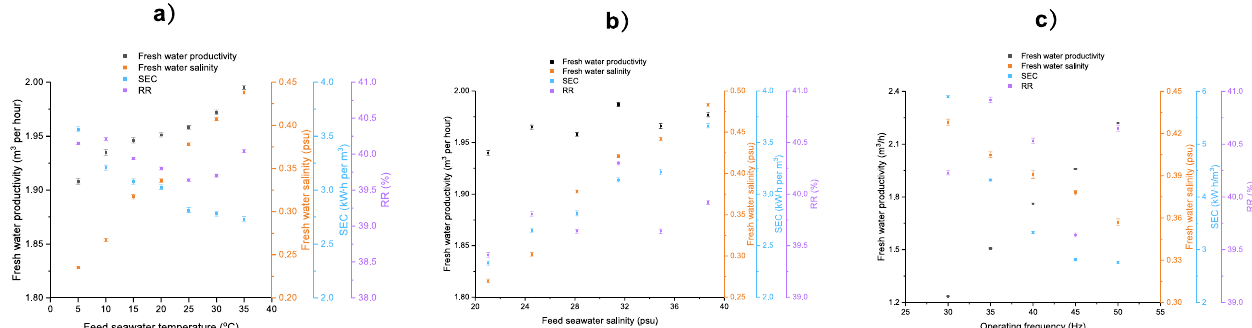
Fig. 1 System performance fl uctuations under variable operating conditions. a The in fl uences of feed seawater temperature on fresh water salinity, SEC of RO process and RR of RO system are portrayed. b The in fl uences of feed seawater salinity on fresh water salinity, SEC of RO process and RR of RO system are portrayed. c The in fl uences of operating frequency on fresh water salinity, SEC of RO process, and RR of RO system are portrayed. Error bars indicate the standard deviation.